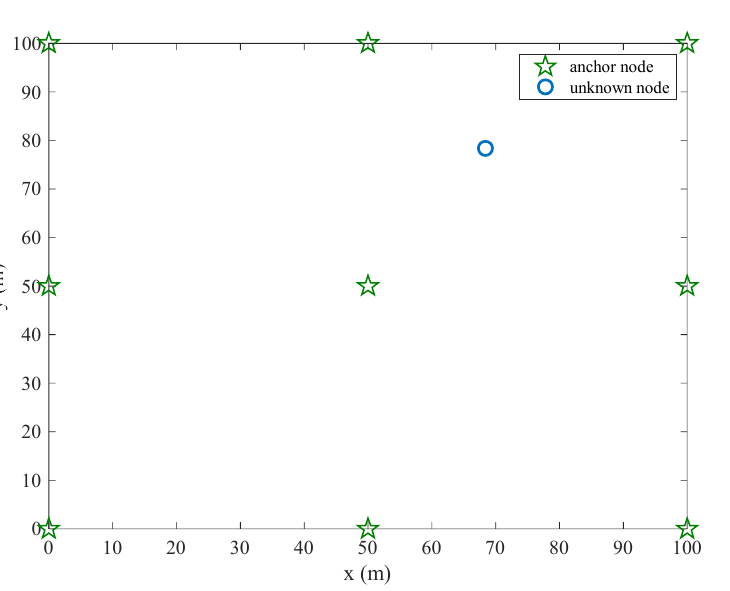
Figure 5. The positioning scenario and setting.